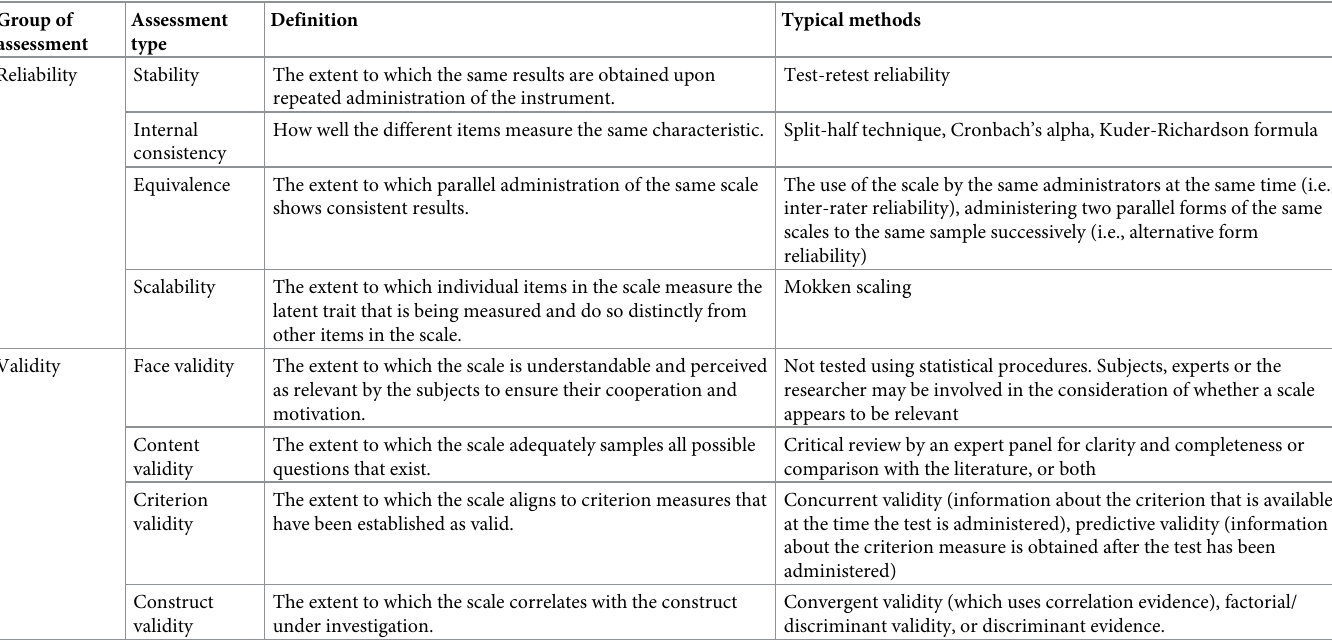
Table 2. Reliability and validity assessments for quantitative